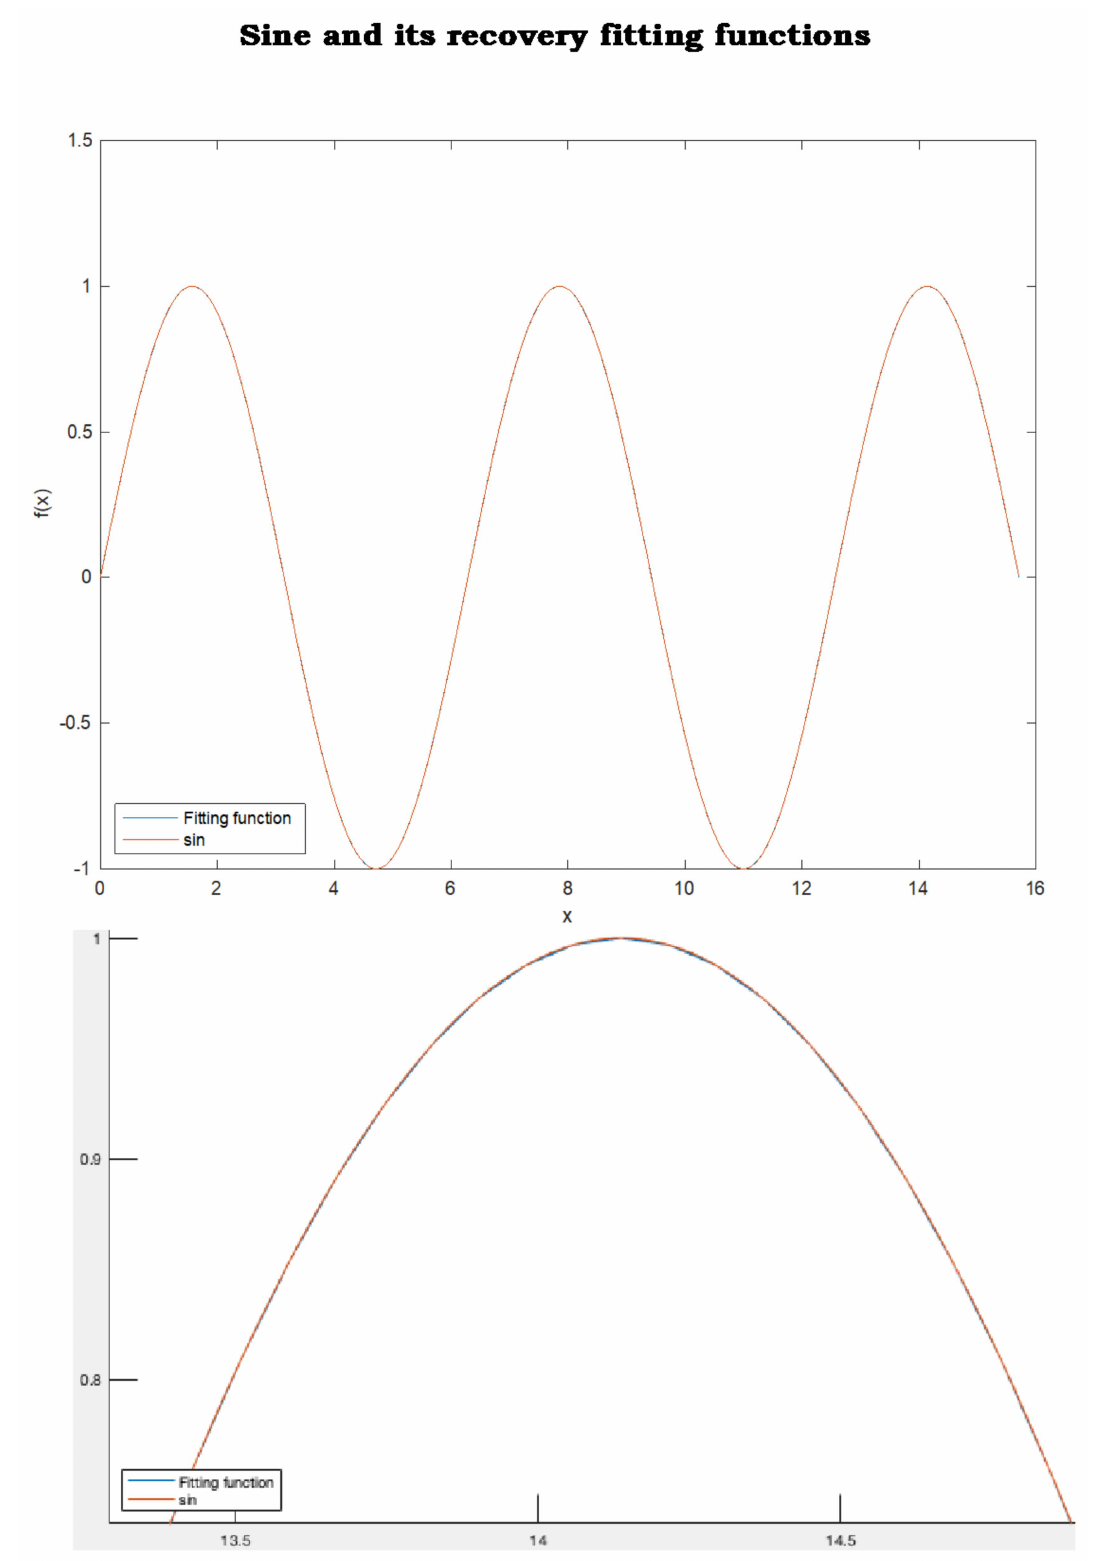
Figure 11. Approximation of sine function over interval [ 0, 5 π ] using 201 uniformly selected sample points. Both functions are almost overlapping over whole interval [ 0, 5 π ] as shown in top plot. Bottom graph is a magnified window to manifest a little contrast and visualize with more certainty high recovery accuracy. This example shows that fitting function a solid continuous representation of given discrete